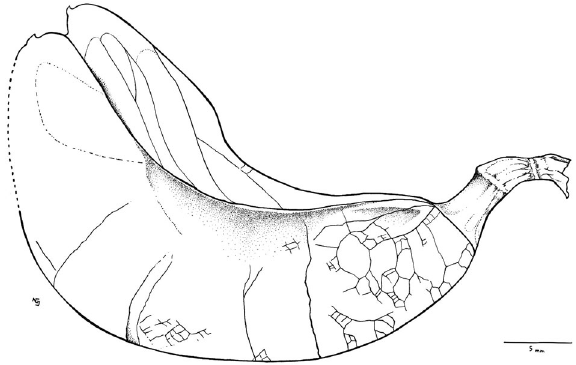
Fig. 2 Line-drawing of Holotype (MUZ-3907). Reconstruction of the fossil fruit, showing fracture lines in the frontal valve, some veins in the epicarp, as well as the suture by which the valves are partially joined. Dotted lines represent areas where the fruit is partially